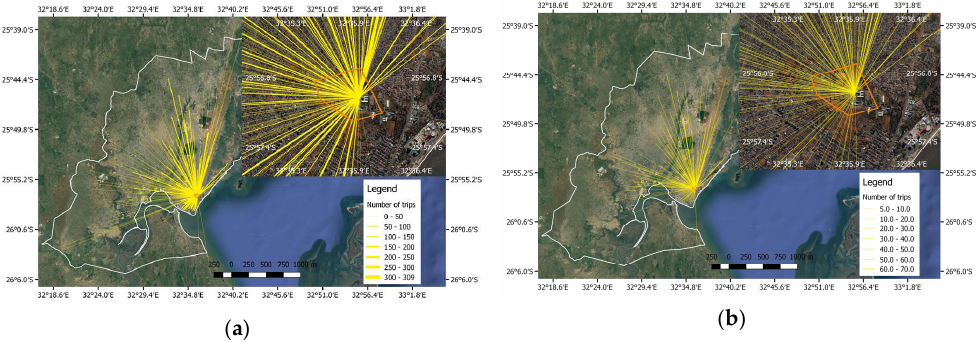
Figure 15. Flow map for trips to Universidade Eduardo Mondlane: ( a ) on weekday, and ( b ) on weekend.